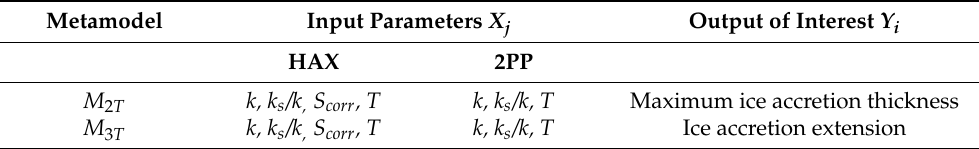
Table 7. Metamodels used for the temperature impact